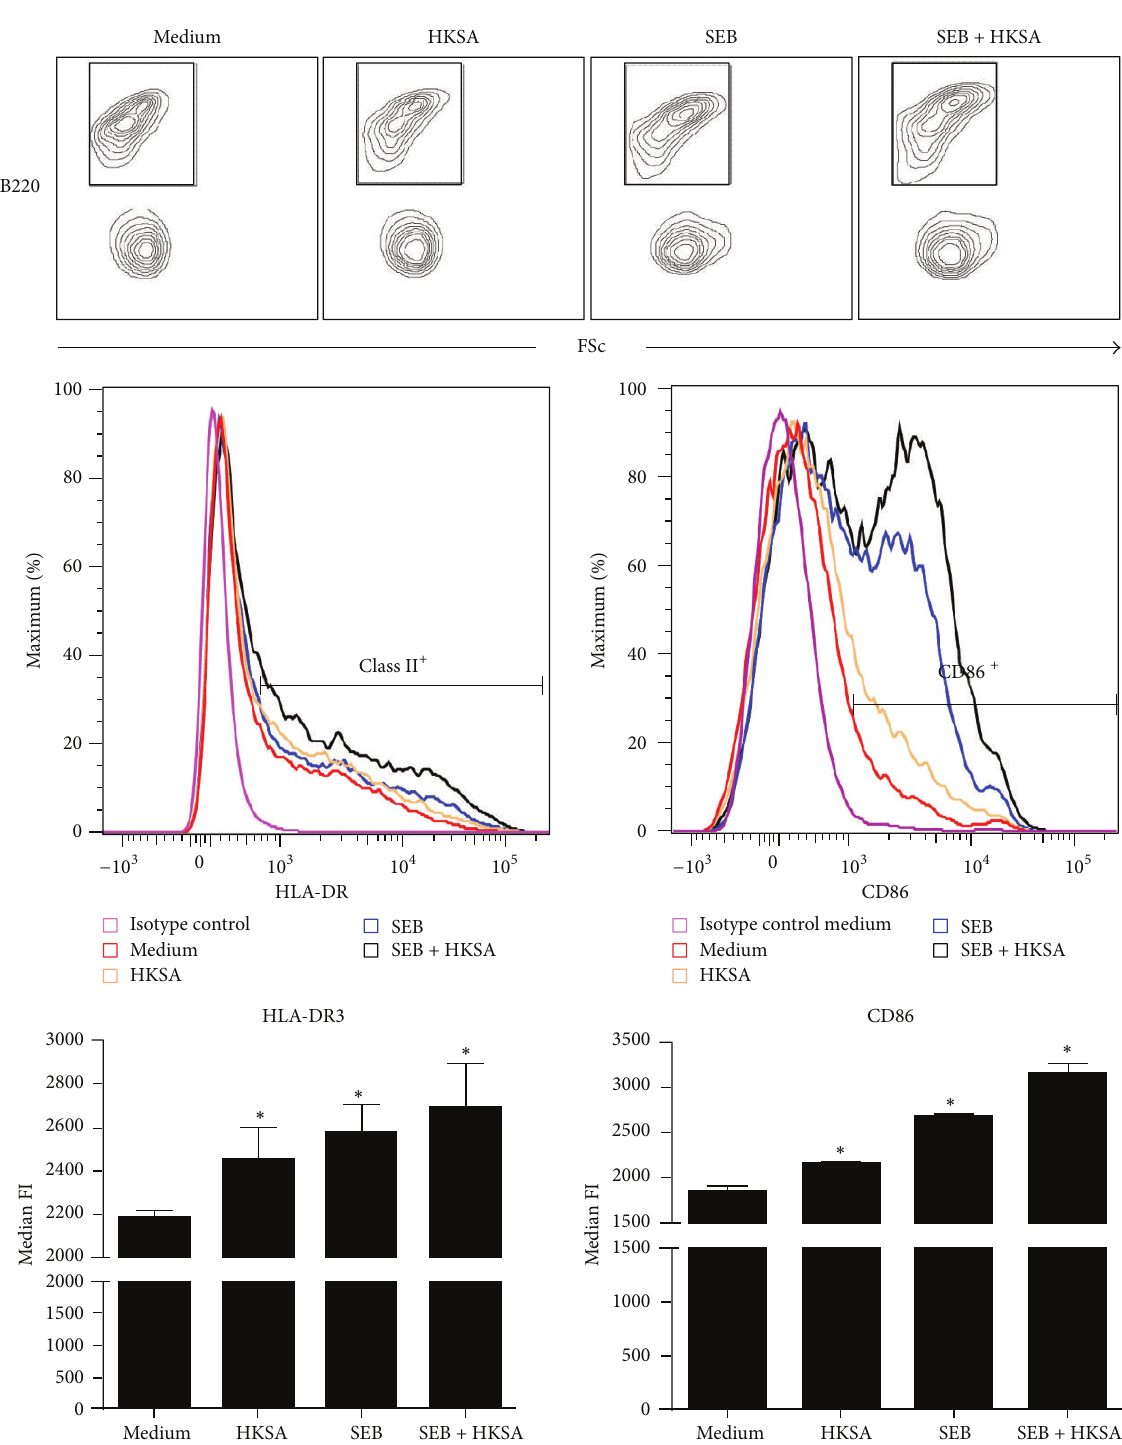
Figure 2: Modulation of expression of HLA-DR3 and CD86 on B220 + cells by HKSA. Splenic mononuclear cells from HLA-DR3 transgenic mice were cultured with medium, HKSA (10 8 bacteria/mL), SEB (1 𝜇 g/mL), or SEB + HKSA. 24 hours later, the cells were harvested and washed and expression of HLA-DR3 and CD86 on B220 + cells was analyzed by flow cytometry. Mononuclear cells were first gated based on forward and side scatter profiles. Other analyses were performed on cells within this gate. Representative histogram profiles and bar charts depicting median fluorescent intensity (MFI) are given. Each bar represents mean ± SE from 2 different experiments, each performed in triplicate. ∗ 𝑃 < 0.05 compared to cells cultured with